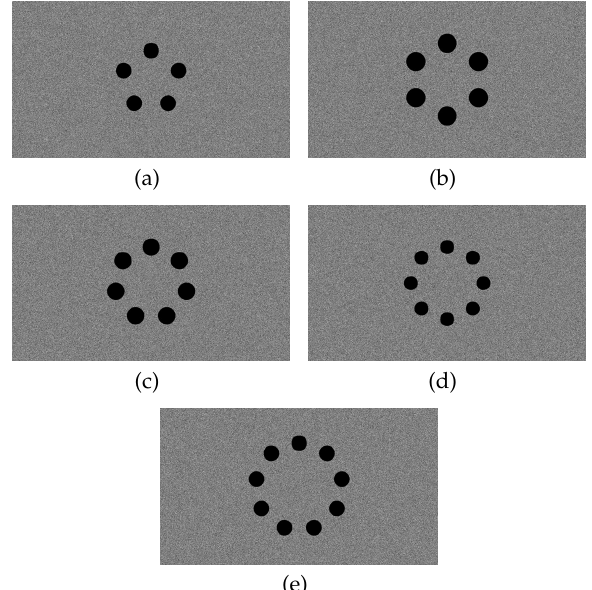
Figure 2 . Examples of the five stimulus types (in terms of the number of objects contained) used in the eye-tracking exper-